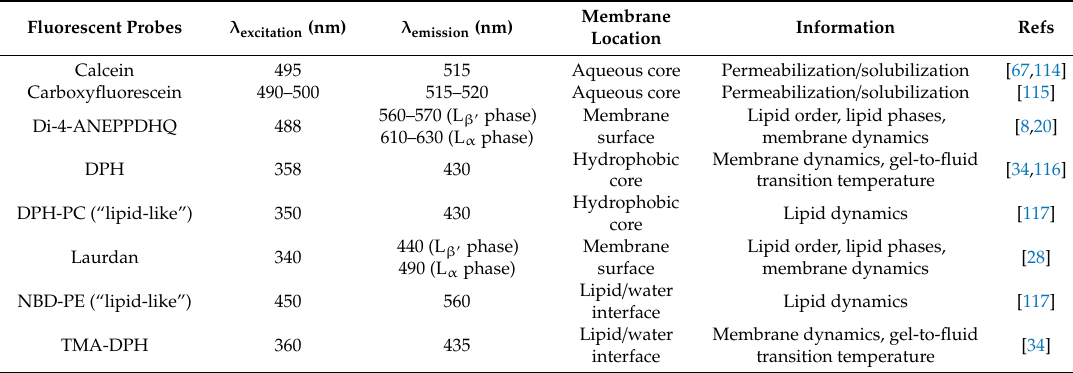
Table 1. Fluorescent probes commonly used to investigate membrane dynamics. Abbreviations: Di-4-ANEPPDHQ: AminoNaphthylEthenylPyridinium derivative; DPH: 1,6-diphenyl-1,3,5 -hexatriene; DPH-PC: phosphatidylcholine-grafted 1,6-diphenyl-1,3,5-hexatriene;